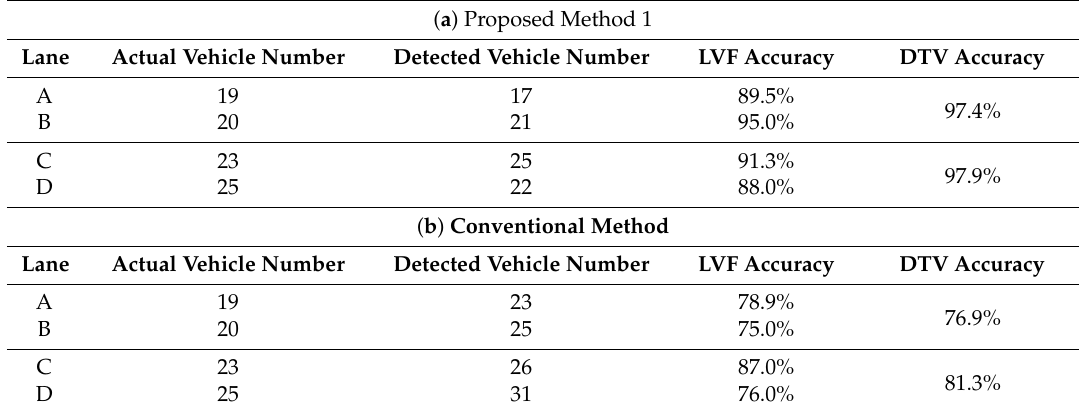
Table 2. Results of LVF and DTV detection during 12:45–12:55 AM (light traffic) using ( a ) proposed method 1 and ( b ) conventional method.